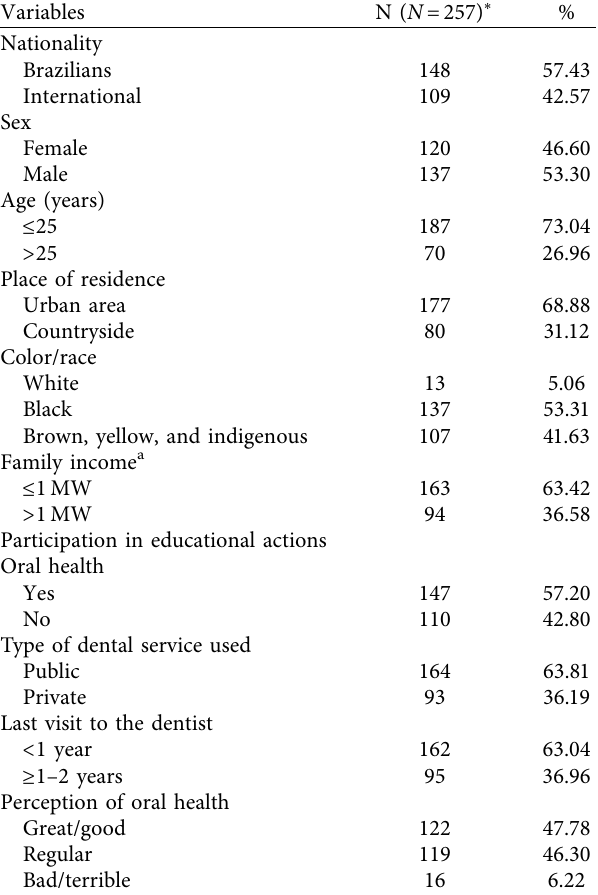
Table 1: Description of sociodemographic, economic, and oral health-related aspects of only Brazilian and international academics who used dental services. Redenção e Acarape, CE, Brazil, 2019.